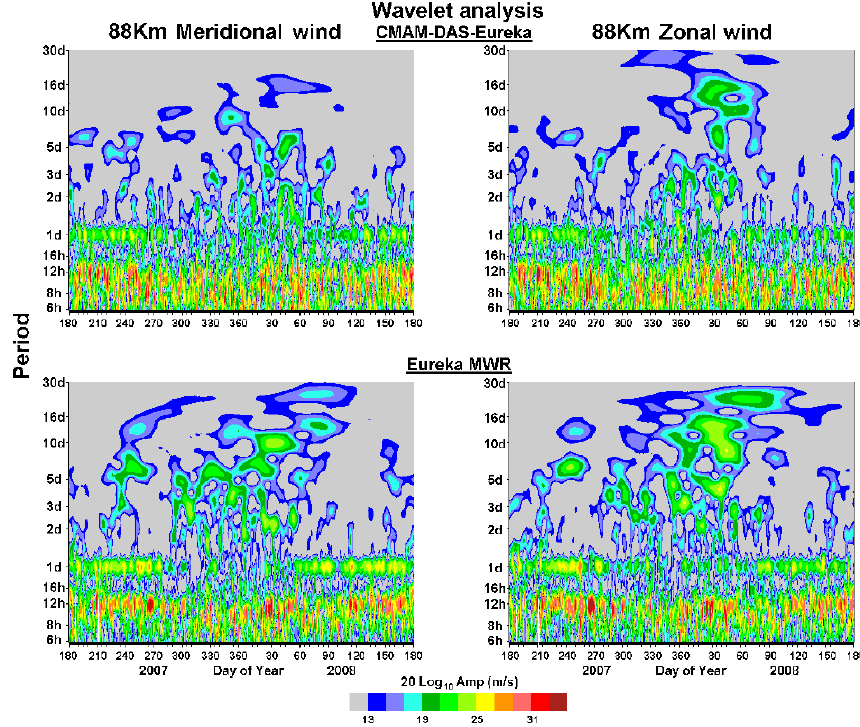
Fig. 6. Wavelet analyses as applied to winds data from the High Arctic radar and CMAM-DAS at Eureka (80 ◦ N, 86 ◦ W). The observed seasonal tidal variations are larger than modeled, as is the observed planetary wave